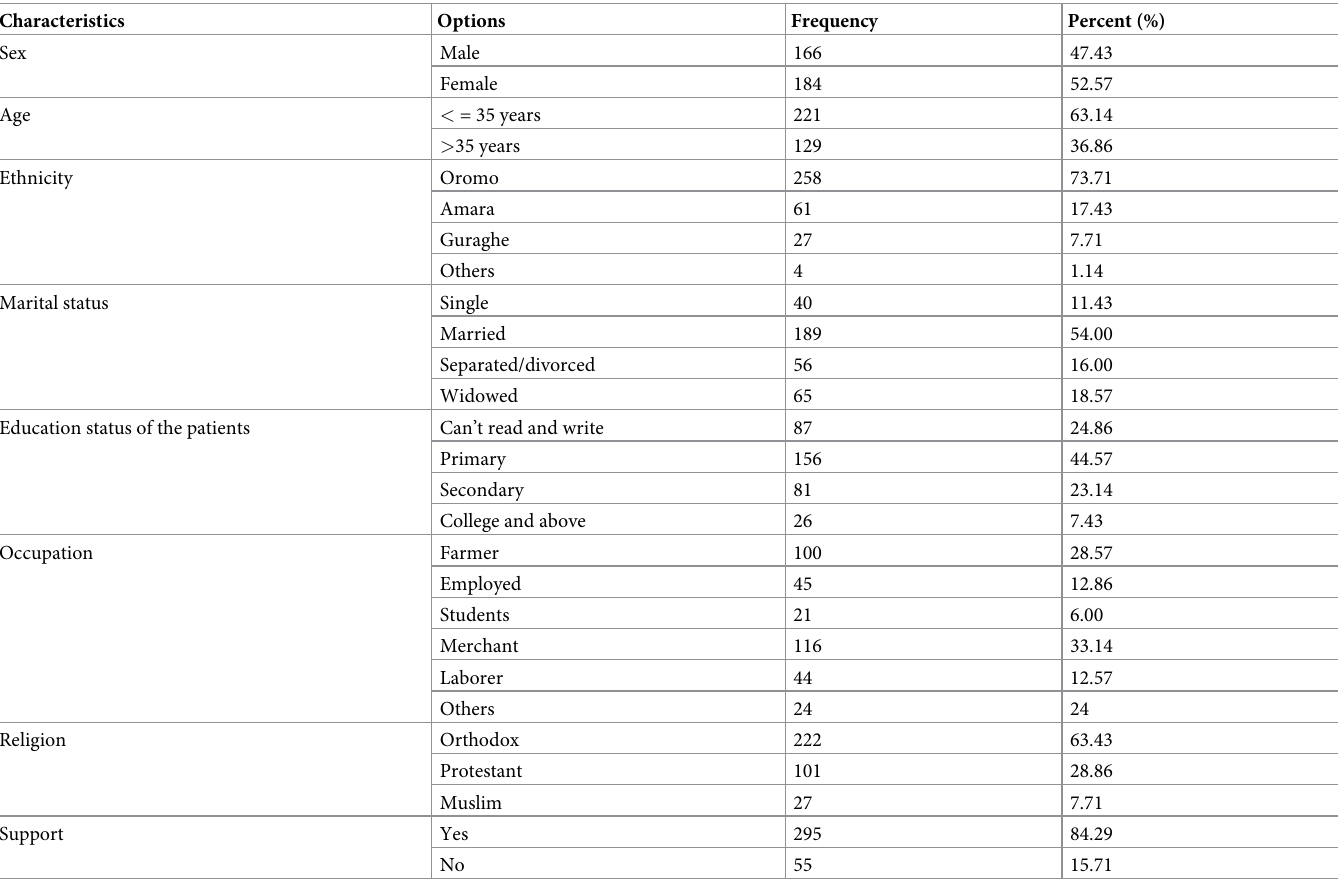
Table 1. Socio-demographic characteristics of patients taking ART drugs at ART at public health facilities in South West Shoa Zone, 2019.